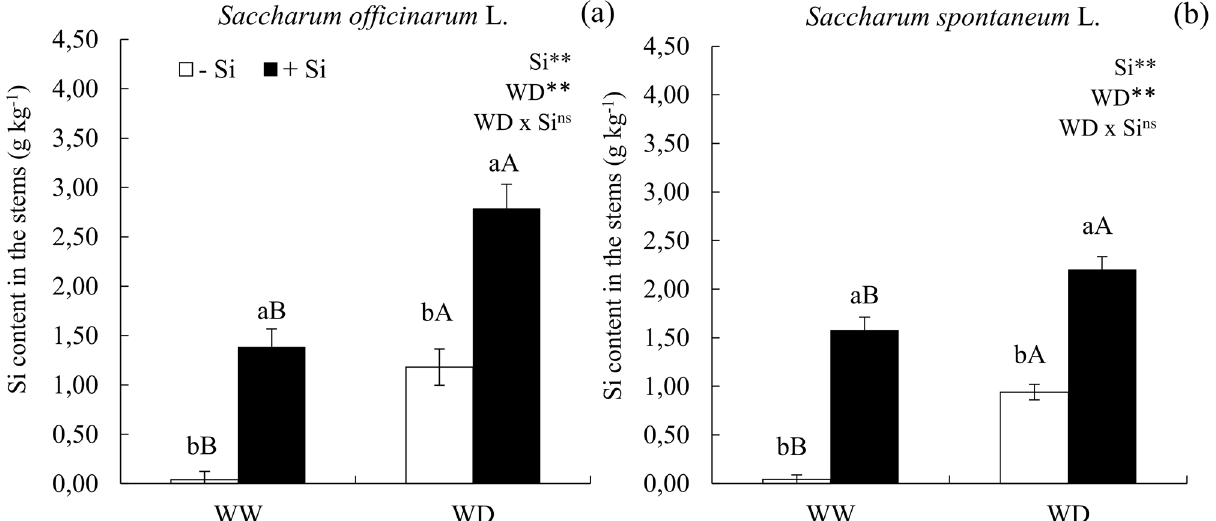
Figure 1. Silicon (Si) content in the stems of ratoon of sugarcane ( Saccharum officinarum L.) ( a ) and energy cane ( Saccharum spontaneum L.) ( b ) cultivated without water deficit-WW (70% of soil water retention capacity—WRC) and with water deficit-WD (30% of WRC) without (− Si) and with (+ Si) application of Si via fertigation associated with leaf spray. **Significant at 1% probability; and ns not significant for main effects and interaction, by the F-test. Lowercase letters show differences in relation to Si and uppercase letters in relation to WD. Bars represent the standard error of the mean. Si × WD: